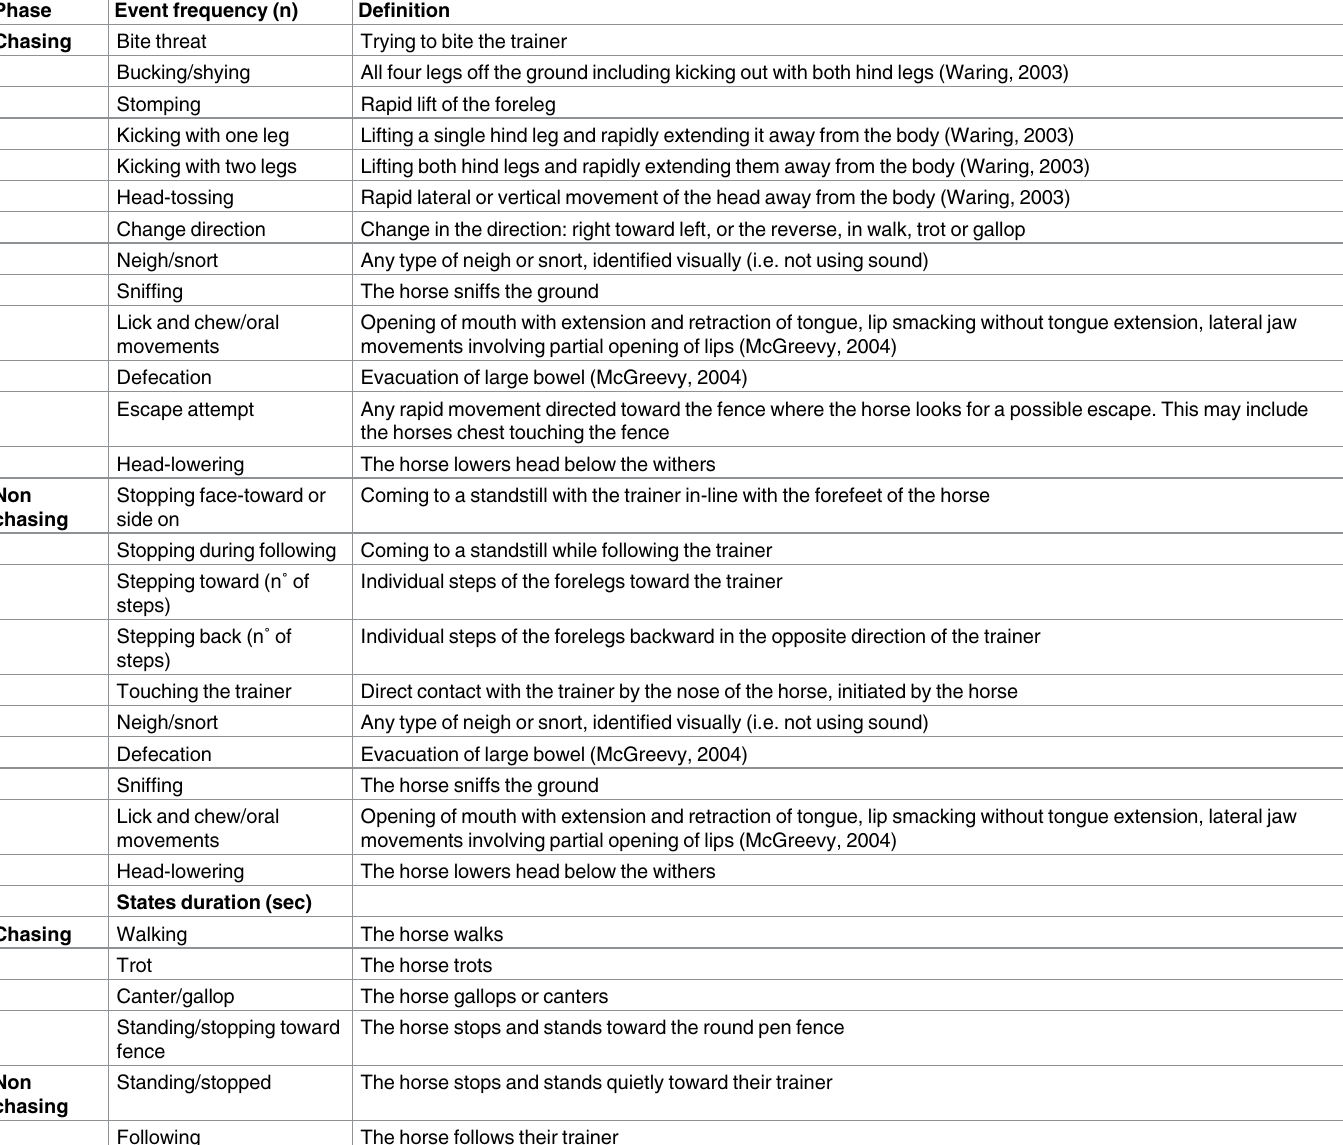
Table 1. Behavioural states and events selected in the focal sampling